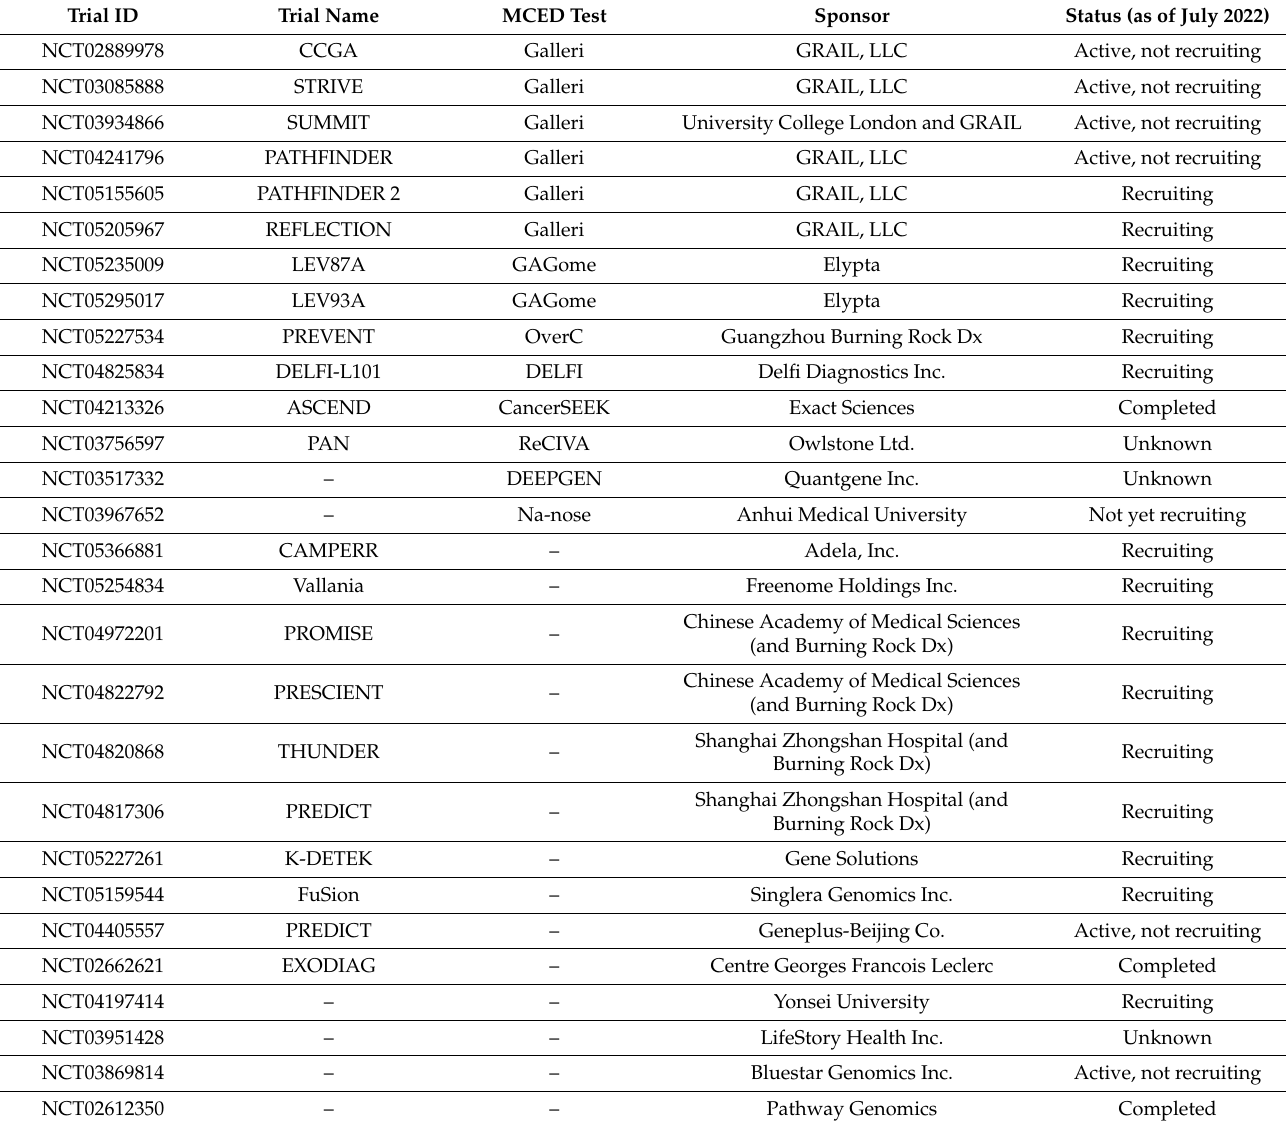
Table 3. Clinical trials conducted/ongoing for validation of multi-cancer early detection